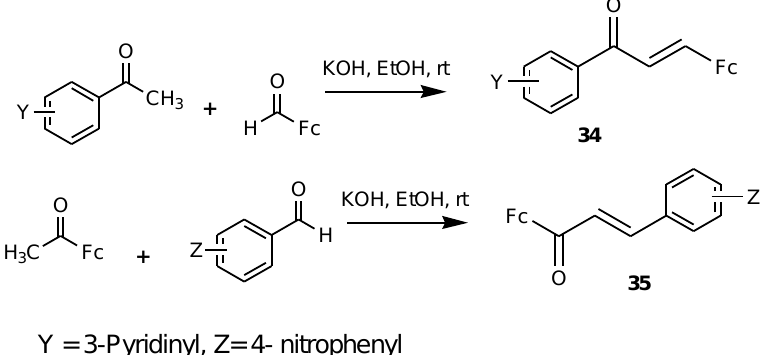
Figure 15. Ferrocenyl chalcones derivatives ( 34 – 35 ).